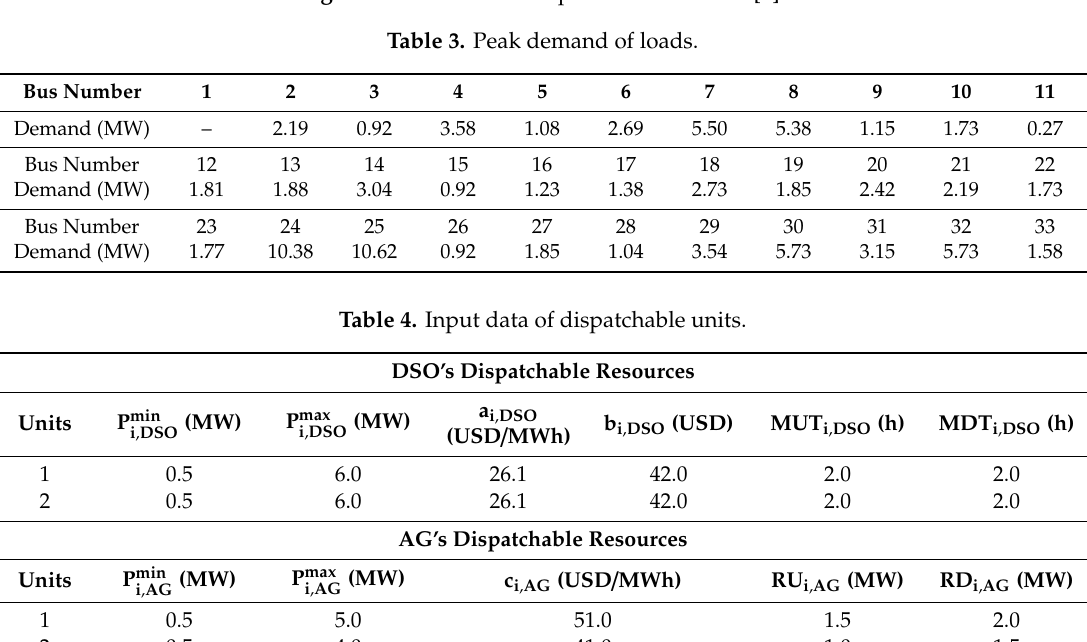
Table 4. Input data of dispatchable units. Table 5. Input data of non-dispatchable